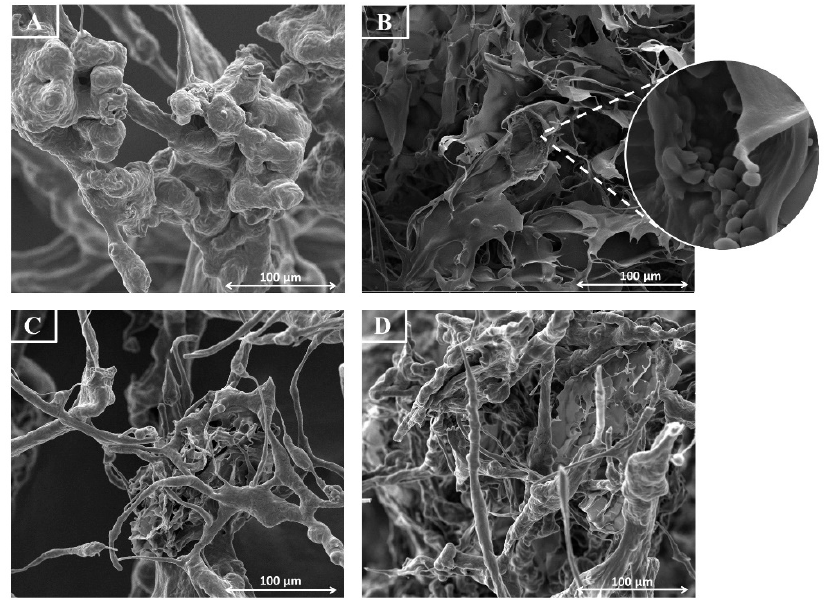
Figure 7. Representative SEM images for dipolymeric systems with TG/CS ratio of 10:1 ( A ) and 7:1 ( B ), and tripolymeric formulations with TG/XG/CS ratio of 10:1:1 ( C ) and 7:0.7:1 ( D ) under 1000 × magnification (inset—under 10,000 × ).